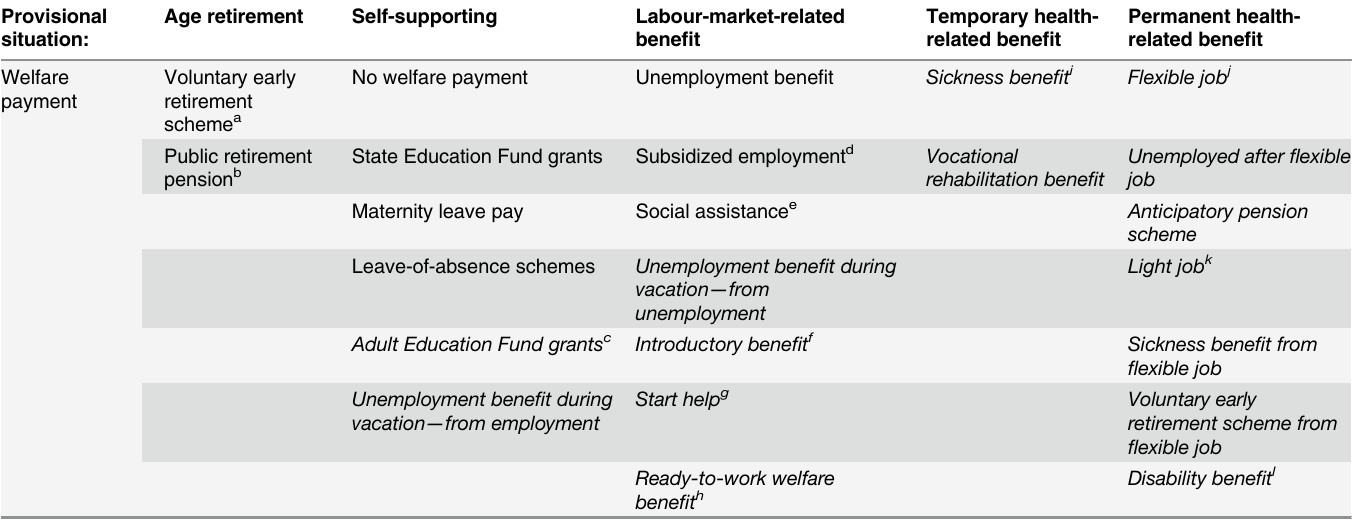
Table 1. Categorization of provisional